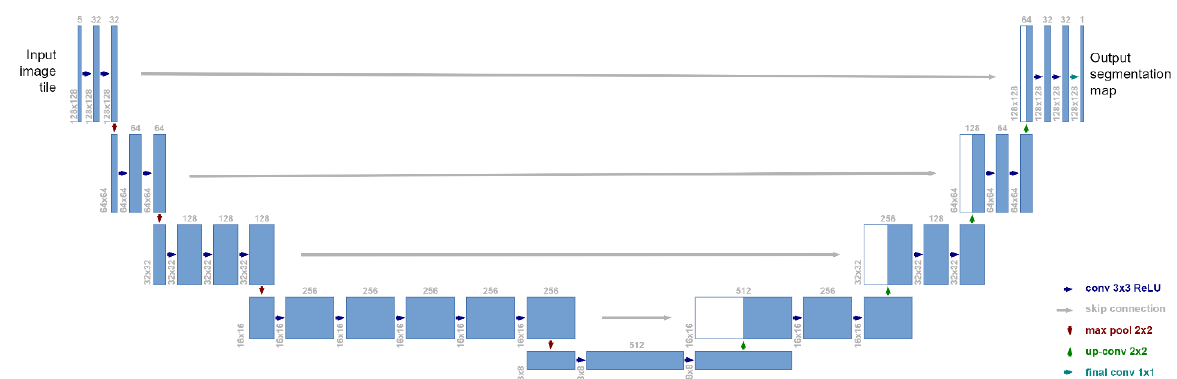
Figure 6. Proposed adapted U-net architecture.